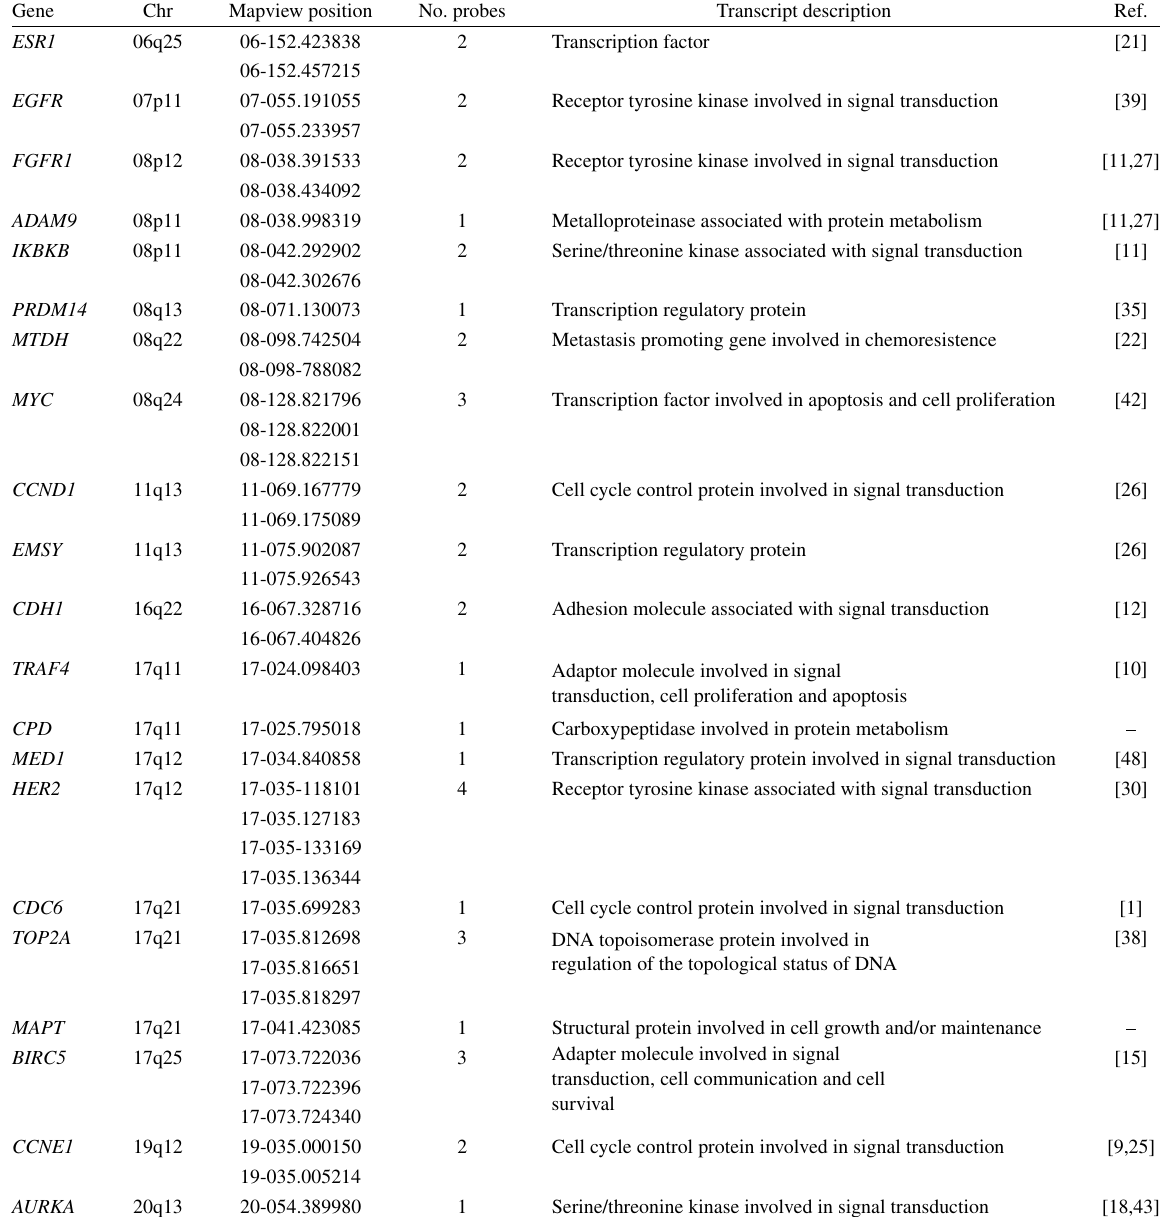
DNA topoisomerase protein involved in regulation of the topological status of